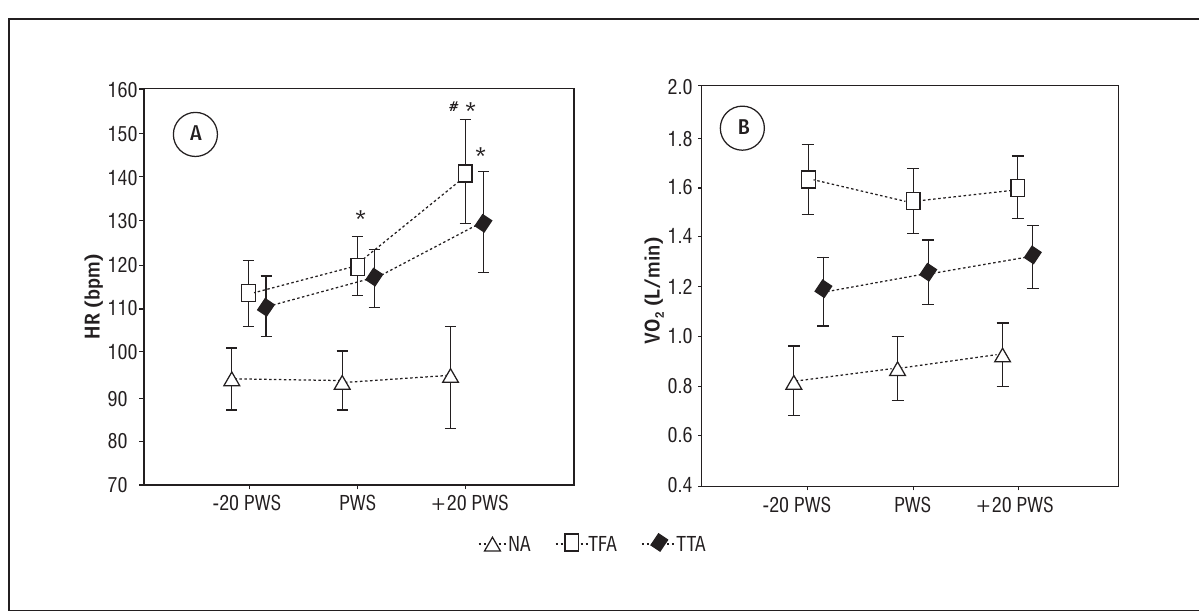
), graphs A and B, respectively, with 2